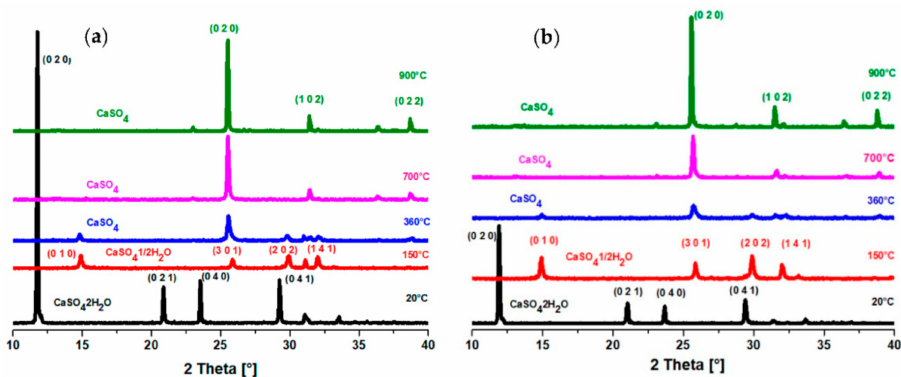
Figure 6. XRD diagrams of AG ( a ) and SG ( b ) minerals at di ff erent temperatures.